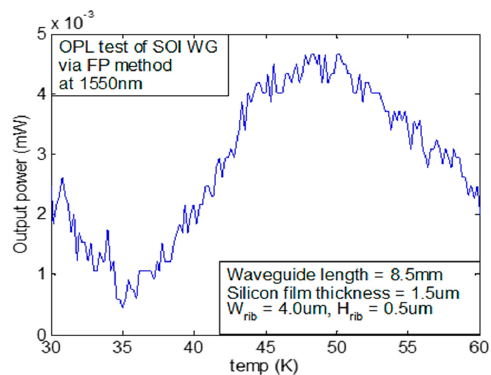
Figure 6. Measurement output curve of Fabry–Perot (F-P) resonance of the SOI waveguide vs. temperature.